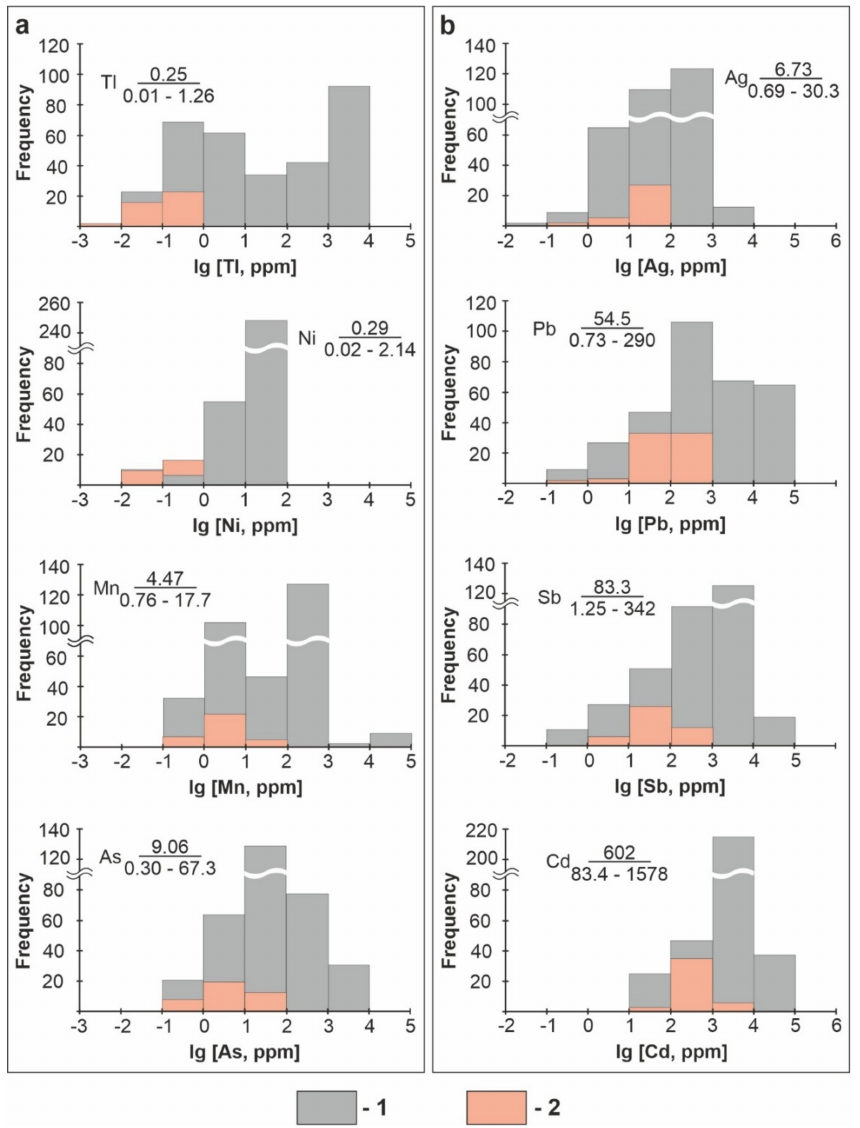
Figure 21. Trace-element contents in sphalerites from Pugachev and South Sakhalin MVs compared to those from the low-temperature (T < 200 ◦ C) sphalerites from different Pb-Zn deposits worldwide: ( a ) very low, ( b ) low. 1 = trace-element contents (LA-ICPMS data) in sphalerites from Vein-type and Mississippi Valley-type Pb-Zn deposits of Romania [1], China [8], Germany [16] and Iran [105]. 2 = trace-element contents (LA-ICPMS data) in Sakhalin MVs sphalerites. The numbers next to the histograms are element contents: average values above the bar and the averaging range below the